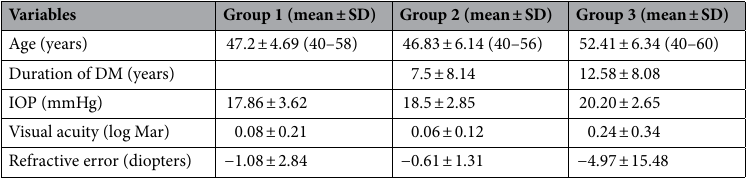
Table 7 and 8 represent the stepwise multiple regression analysis using GST, vitamin C, and GSH as dependent variables. Figure 2a,b demonstrate the ROC analysis of the measured biochemical markers in diabetic with and without retinopathy. Among the four parameters, vitamin C and GSH demonstrate predictive values. Table 9 represents the remarkable increase of the area under the curve (AUC) of combined vitamin C and GSH.